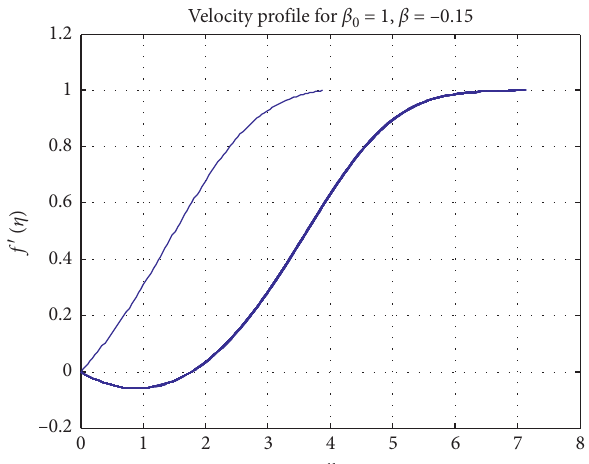
Figure 10: Velocity profile for β � − 0 . 15, Δ L � 0.001; f ″ ( 0 ) � 0.233877086171824 (Forward flow), L � 3.88; f ″ ( 0 ) �− 0.133696366858524 (reverse flow), L �